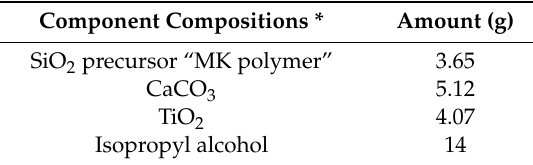
Table 1. Suspension composition.